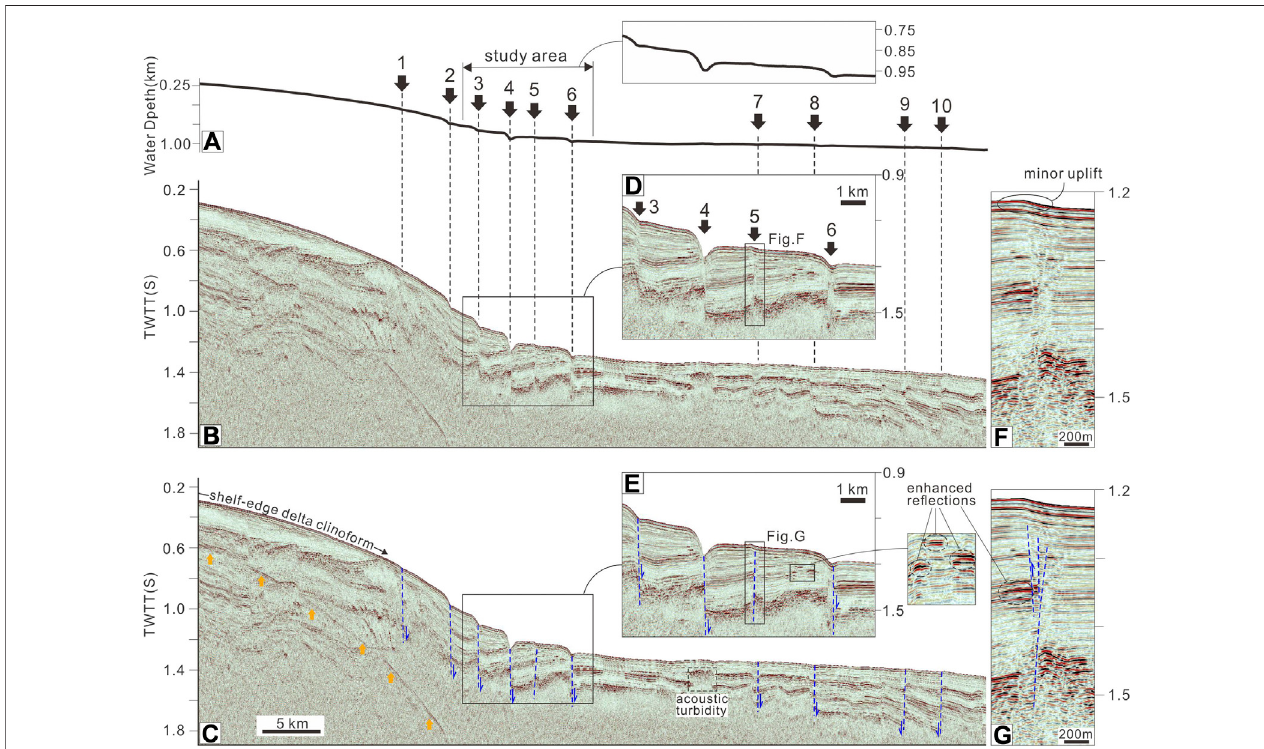
FIGURE 3 | (A,B) A representative seismic cross section and its bathymetric pro fi le. Its location is marked in Figure 2A . The presence of the faults marked by numbers1 – 10canbeidenti fi edbothonthebathymetricpro fi leandtheseismiccrosssection (B,C) . (D – G) Zoomed-in fi guresshowingthefaultsandtheirinterpretations. Orange arrows mark the seabed